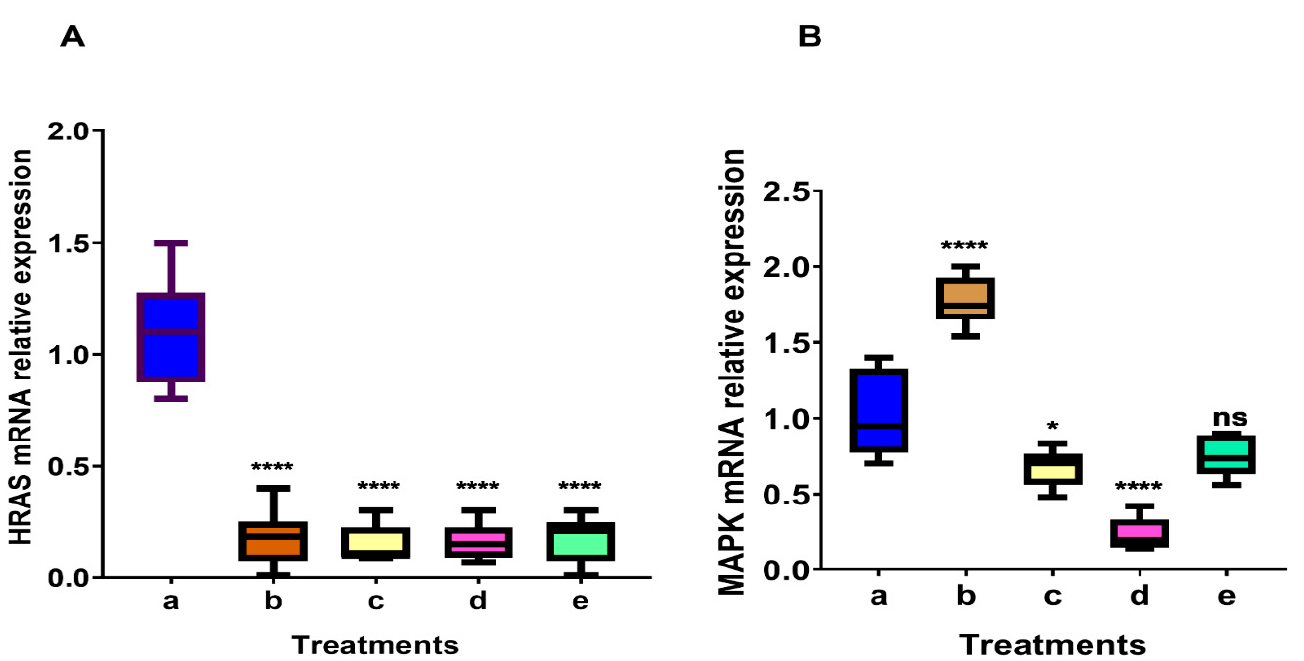
Figure 11. Average qRT-PCR analysis data of the mRNA expression in different A549 treatments. a: untreated cells; b: PCIBP; c: EPCIBP; d: Bev.; e: EPCIBP + Bev. combination normalized relative to the B-actin endogenous housekeeping gene. ( A ) HRAS gene where **** p ≤ 0.0001 vs. untreated cells; ( B ) MAPK gene where * p ≤ 0.02, **** p ≤ 0.0001, ns: nonsignificant vs. untreated cells.